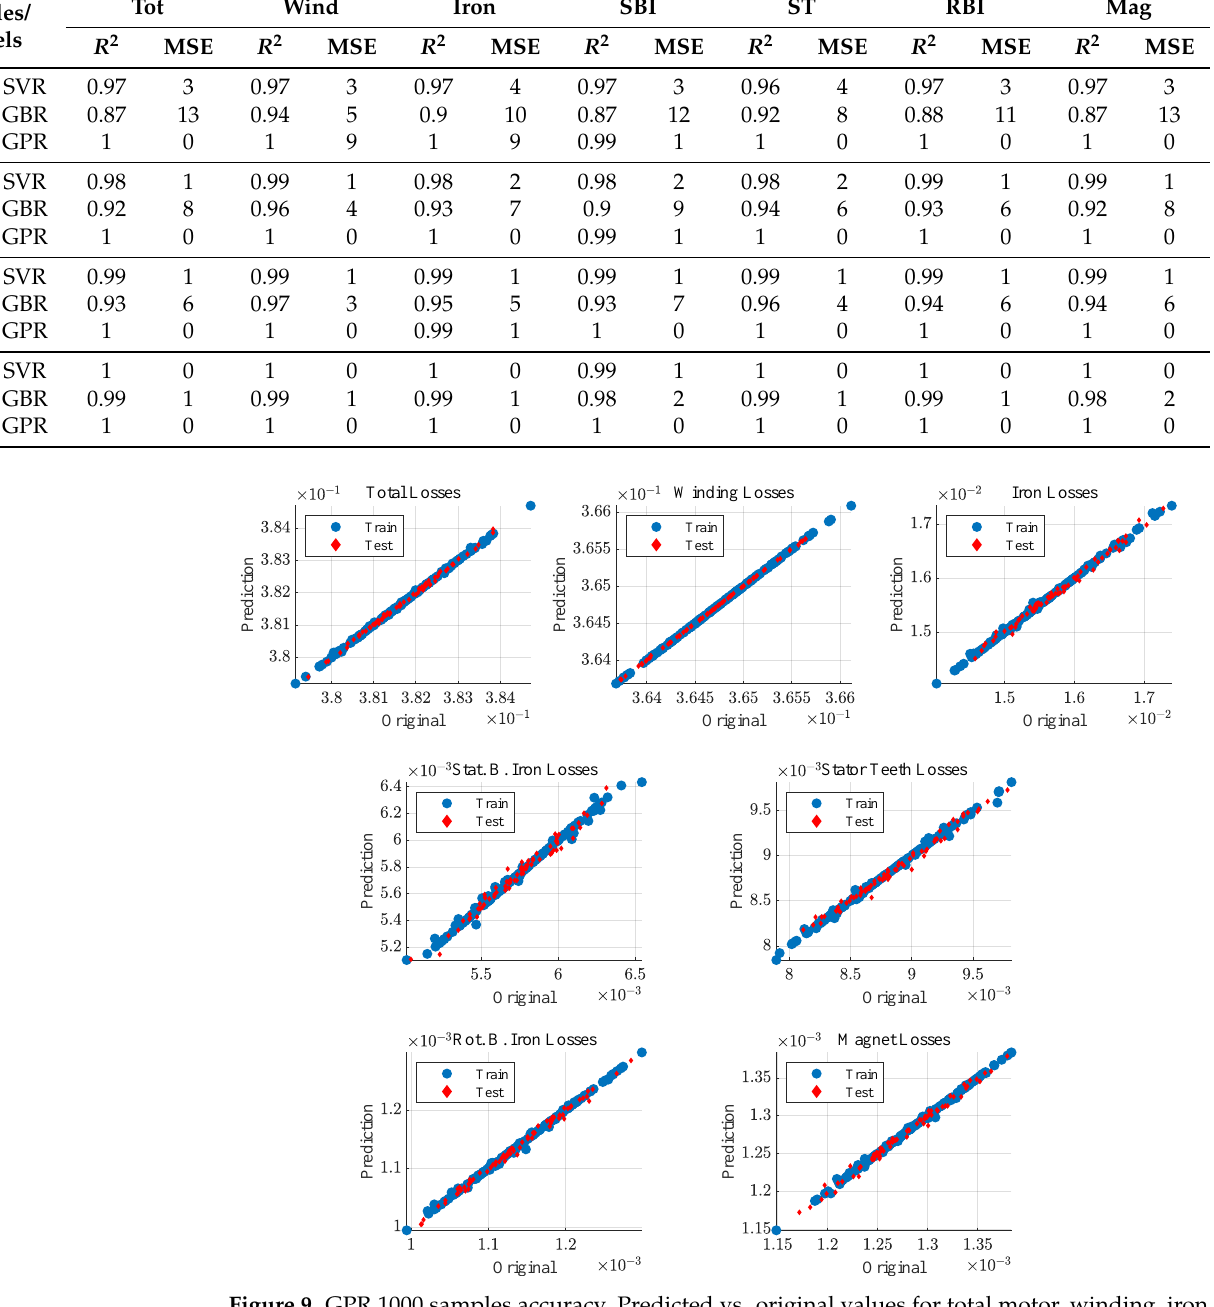
Figure 9. GPR 1000 samples accuracy. Predicted vs. original values for total motor, winding, iron, stator back iron, stator teeth, rotor back iron and magnets